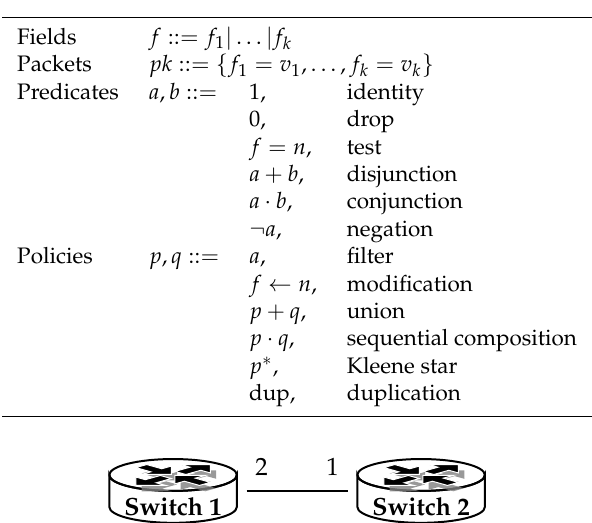
Table 1. NetKAT syntax [6].